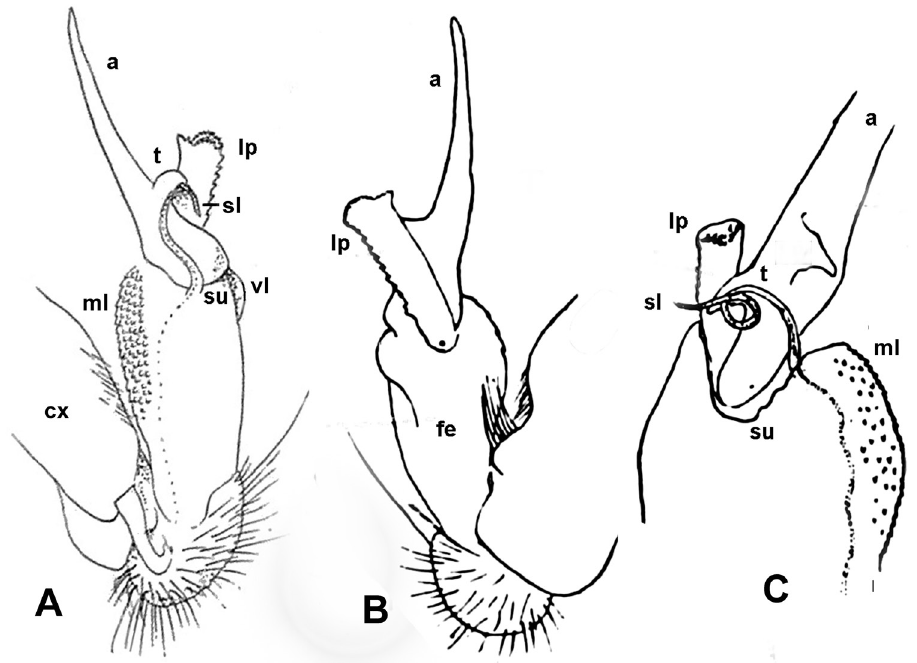
Figure 4. Annamina xanthoptera Attems, 1937, ♂ paralectotype (NHMW), entire left ( A, B ) gonopod and distal part of right one ( C ), mesal, lateral and subventral views, respectively (cx = coxite; fe = femorite, vl = ventral lobe; ml = mesal lobe; su = postfemoral sulcus; lp = lateral process; a = apical process; sl = so- lenomere; t = solenophore tooth). After Attems (1937) ( A ) and Attems (1938) ( B, C